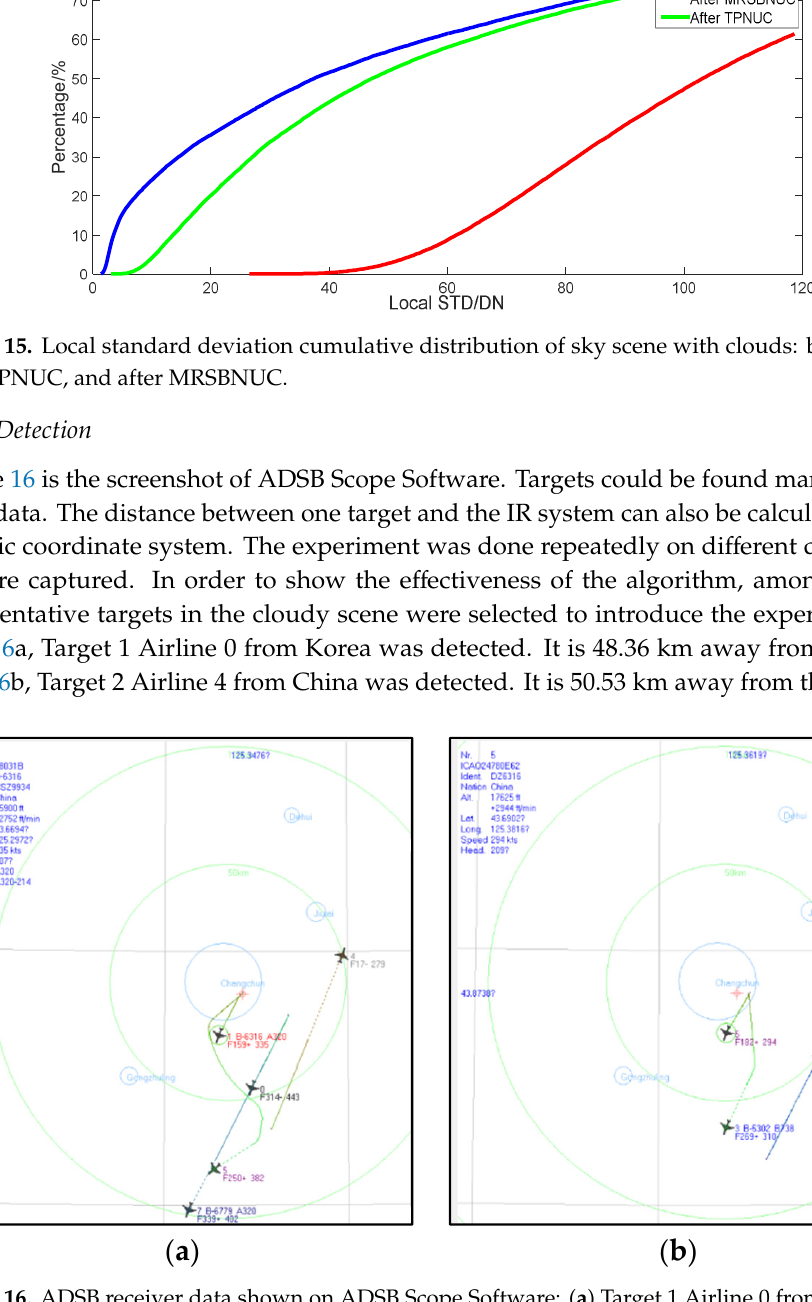
Figure 14. Local standard deviation distribution of sky scene with clouds: before NUC, after TPNUC, and after MRSBNUC.